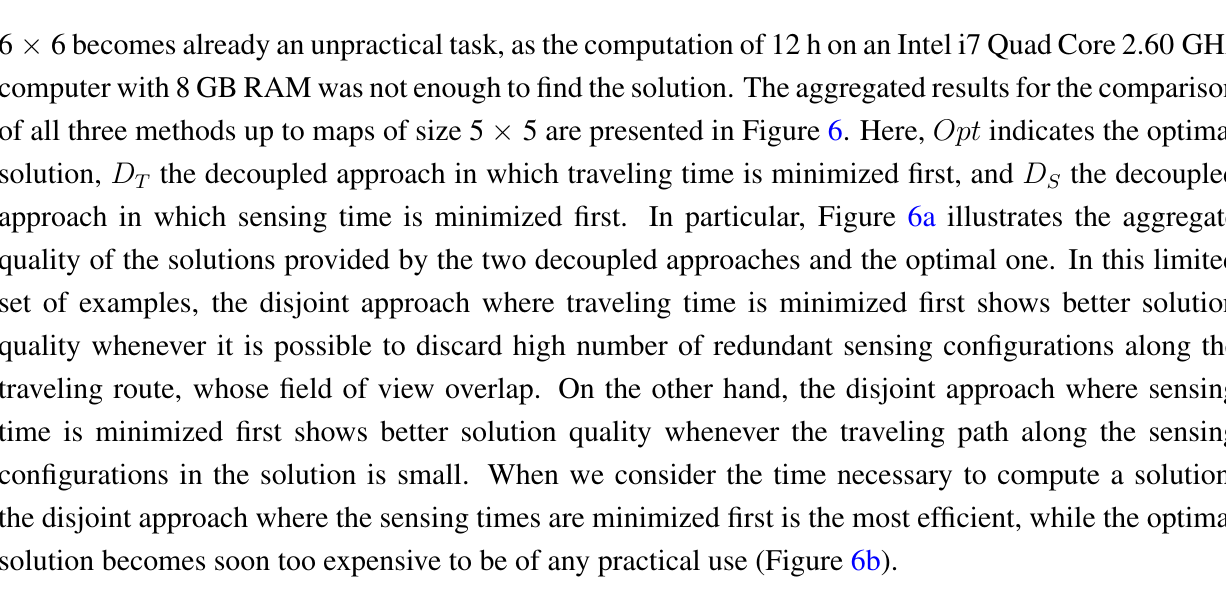
, D ), on three sets T S